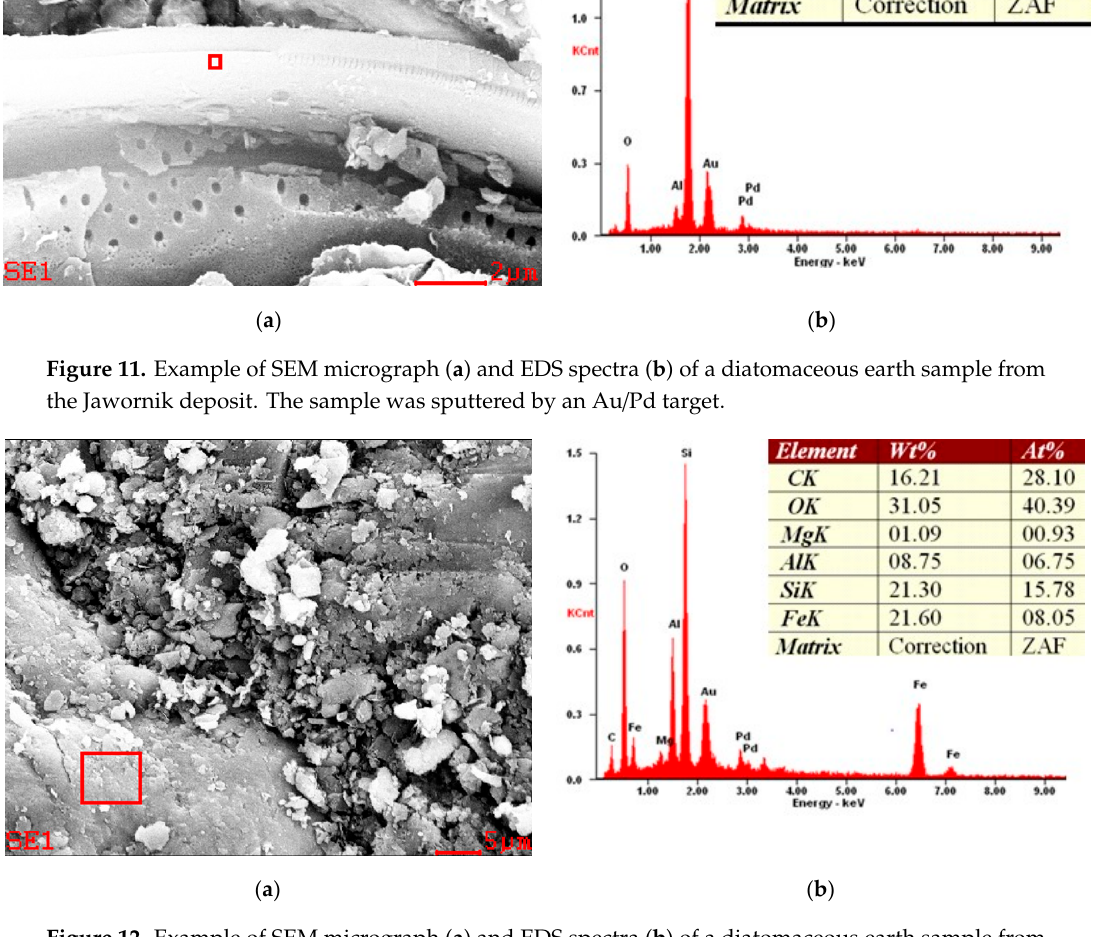
Figure 12. Example of SEM micrograph ( a ) and EDS spectra ( b ) of a diatomaceous earth sample from the Jawornik